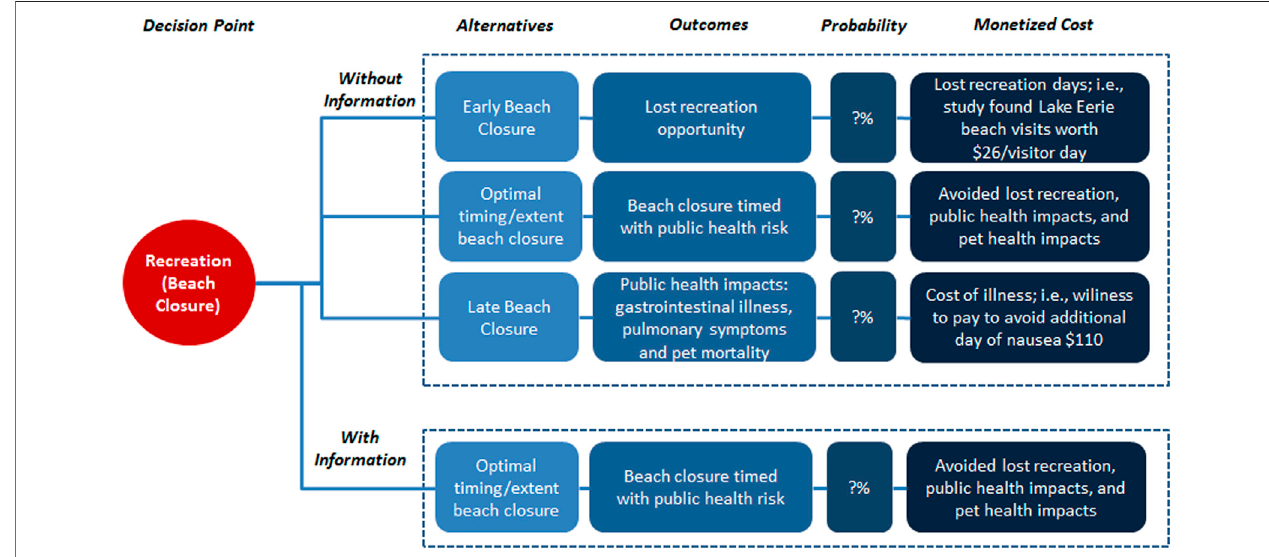
FIGURE 2 | Recreational beach management application of cyanobacteria harmful algal bloom information decision tree.